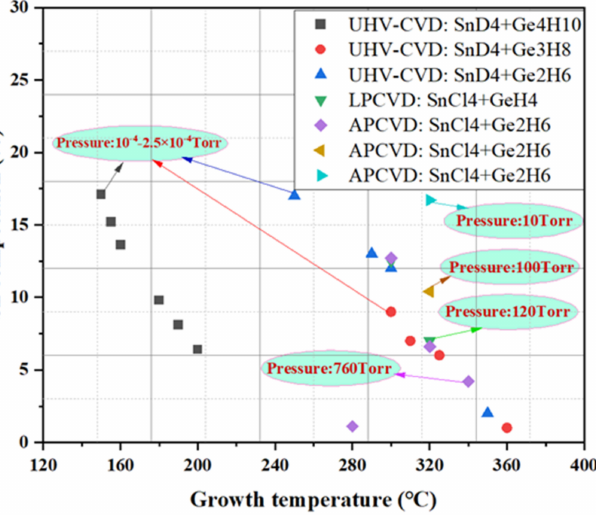
Figure 10. Temperature effect on Sn content from UHVCVD, LPCVD, and APCVD